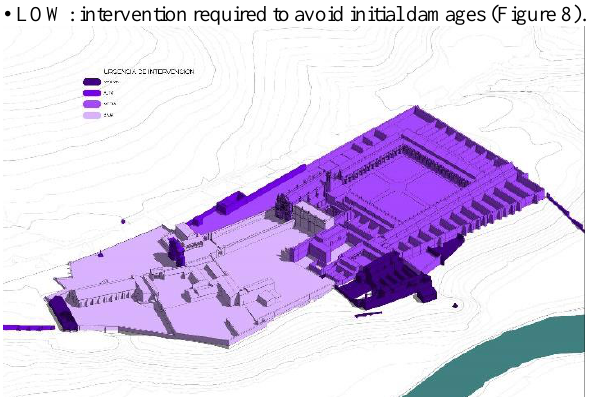
Figure 8: Urgency of intervention. HBIM Charterhouse of Jerez, phase 15, Sisters of Bethlehem (2000-…)